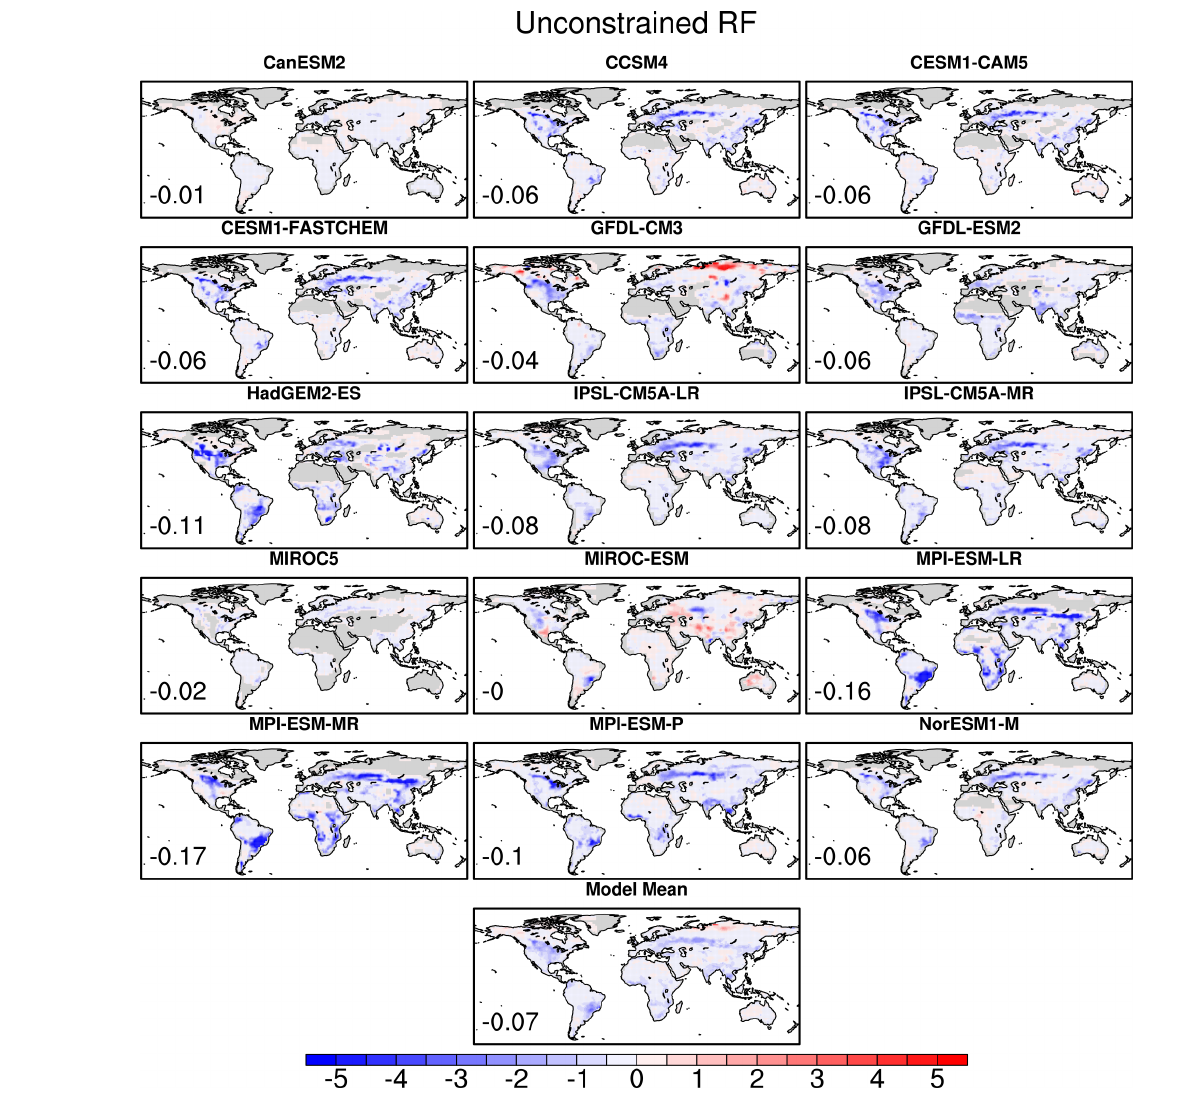
Figure 12. Radiative forcing from historical conversions between trees and crops–grasses (from the pre-industrial to the 1981–2000 period) in the analysed CMIP5 models (in Wm − 2 ), obtained by applying the reconstruction method (see the description of the methodology in Sect. 2.4). The numbers in the bottom left corner of each map indicate the global mean radiative forcing. For the computation of the model mean, if several CMIP5 models contain the same land surface model they were attributed a lower weight so that the sum of their weights equals